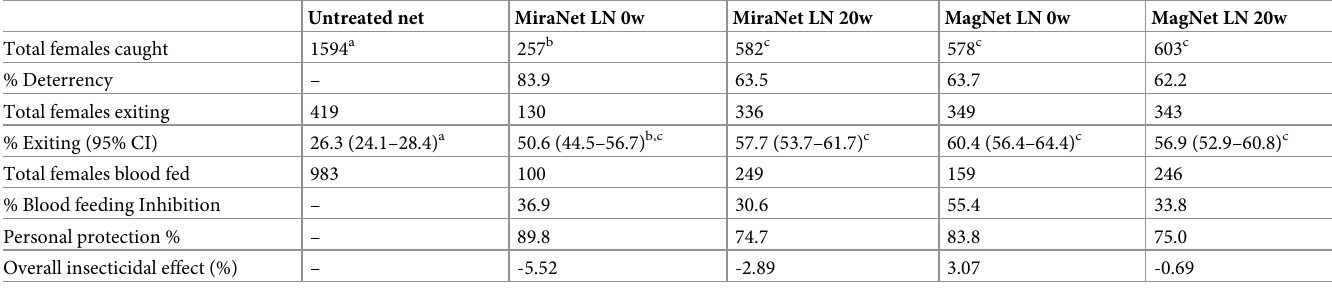
Overall, 3614 An . gambiae s.l. females were caught in huts over the 5-week trial at M’be´ (Table 1). The entry rates of An . gambiae s.l. into huts with insecticide treated nets were 62– 84% lower than entry into huts with untreated nets (p < 0.001) (Table 1). Exit rates of An . gambiae s.l. with unwashed MiraNet and MagNet LNs were significantly greater than untreated net (50–60% vs 26%) and washing 20 times these nets did not decrease the effect (Table 1).